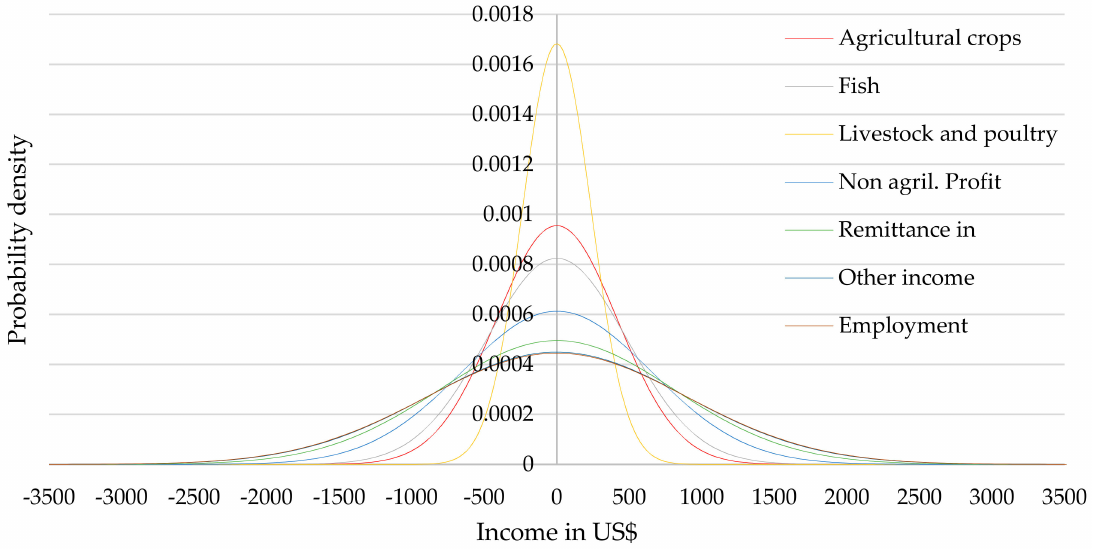
Figure 4. Distribution of total income for farm households in Bangladesh by income sources.